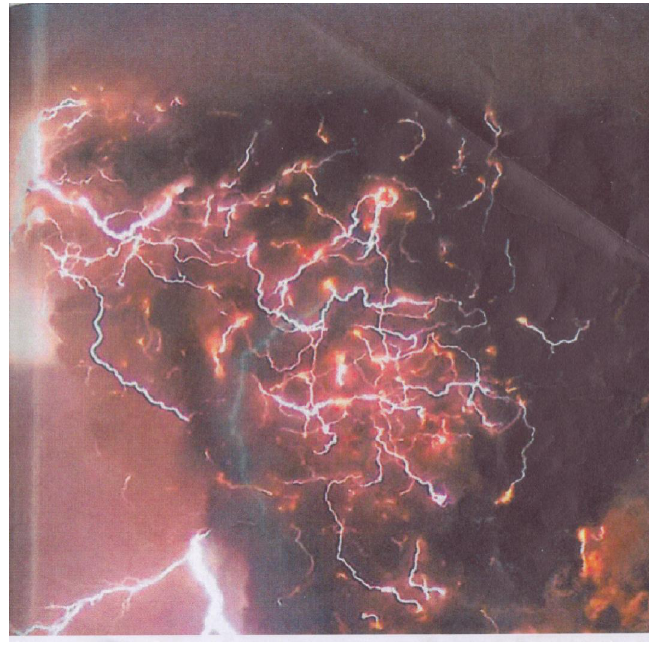
Figure 6. May 2, 2008. Lightning Associated with an Eruption of the El Chaitén Caldera, Chile, 42°50’S 72°39’0. Eruption cloud contains highly charged particles of pumice. (Rhyolitic ash cloud rose to 30,000 meters) Volcanic lightning could have been maximized in the Hadean Eon providing energy for the origin of primary and derivative fumarolic protolife species and other protolife products including cyanogen. Photo credit Carlos Gutierrez, UPI/Digital